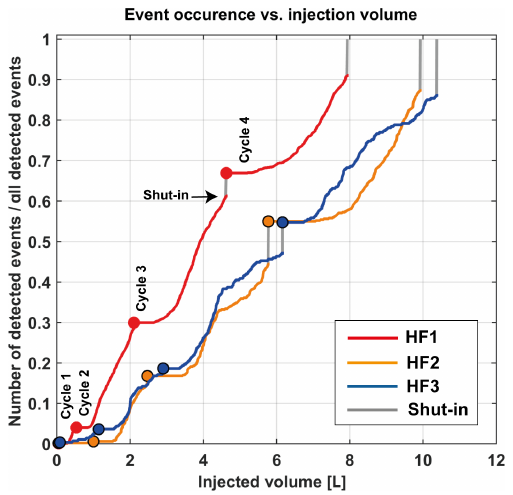
Figure 3. Cumulative fraction of events as a function of cumulative injected volume for hydrofractures HF1-3.